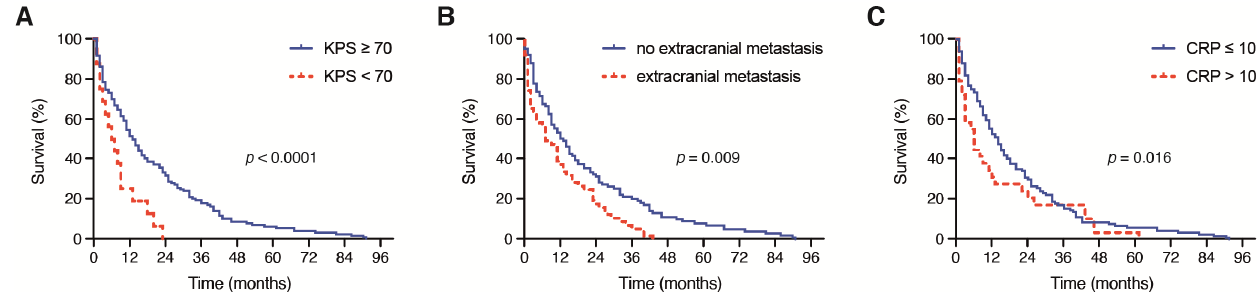
Figure 1. Kaplan–Meier survival curves depicting the influence of ( A ) preoperative KPS (<70, ≥ 70), ( B ) the presence of further extracranial metastases and ( C ) the preoperative CRP value ( ≤ 10 mg/L, >10 mg/L) on the OS in patients with BM derived from NSCLC. BM: brain metastases; CRP: C-reactive protein; NSCLC: non-small cell lung cancer; OS: overall survival.